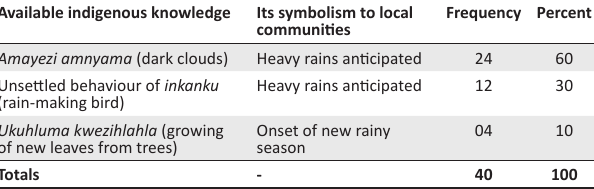
TABLE 1: Disaster risk reduction indigenous knowledge for flood